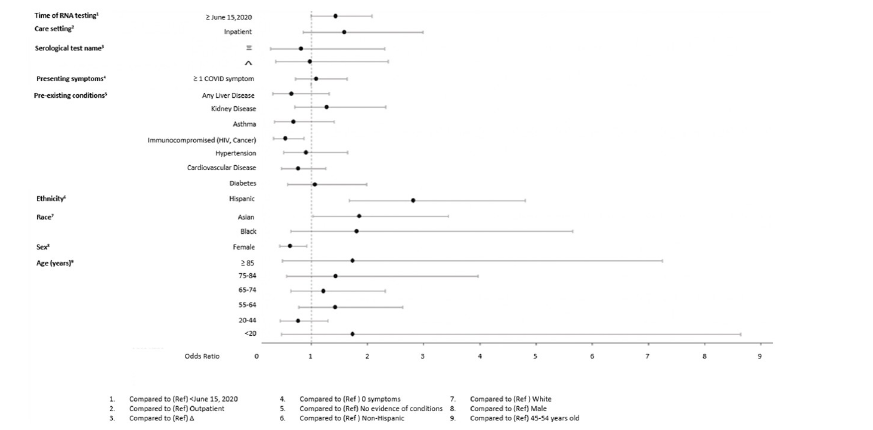
Fig 6. Odds of seropositivity dataset C.